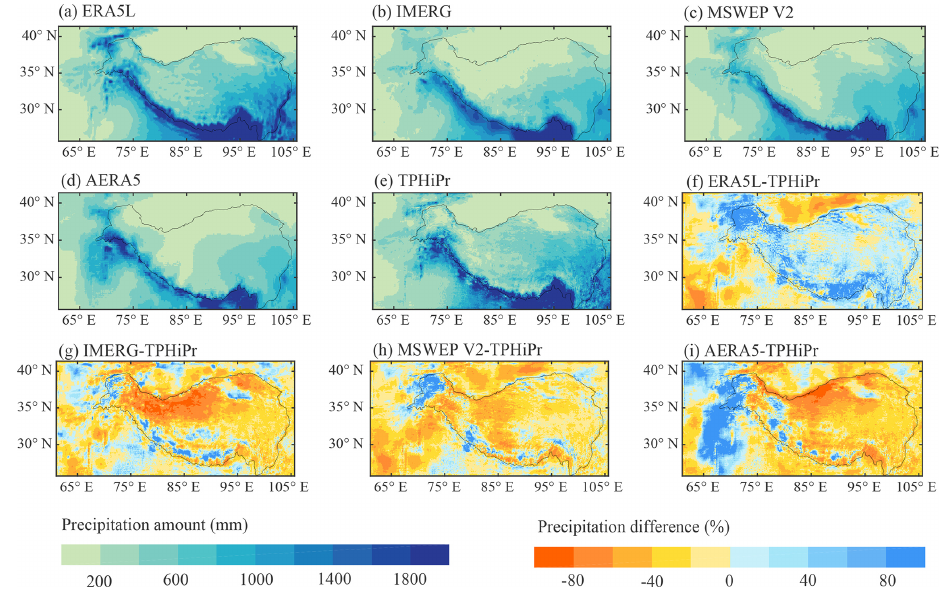
Figure 6. Spatial patterns of (a–e) the average annual precipitation during 2008–2015 from the five datasets and (f–i) the relative differences between TPHiPr and the other four datasets. The differences are calculated by subtracting TPHiPr from the other four datasets and then dividing by TPHiPr.